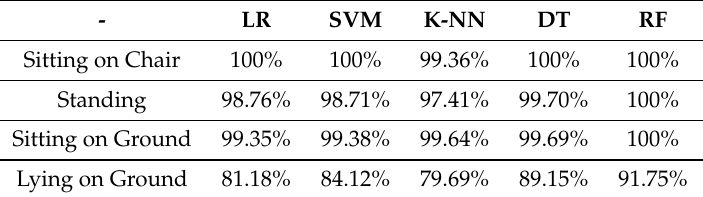
Table 11. Precision rate using different algorithms for two people.